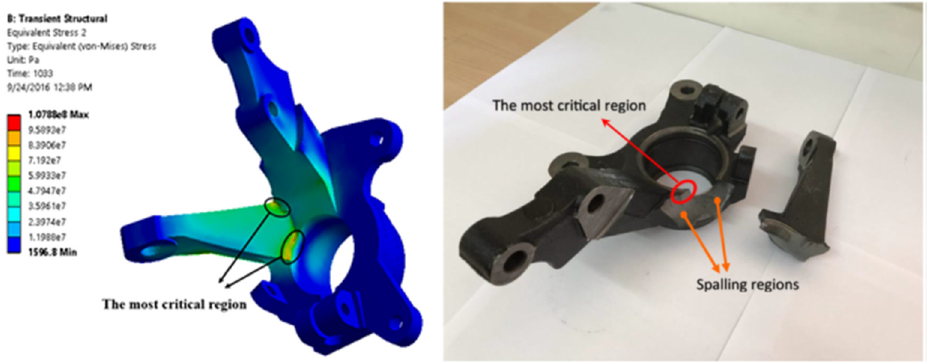
Figure 9. Comparison of fracture location in an experiment with area detection by FEM presented in this study